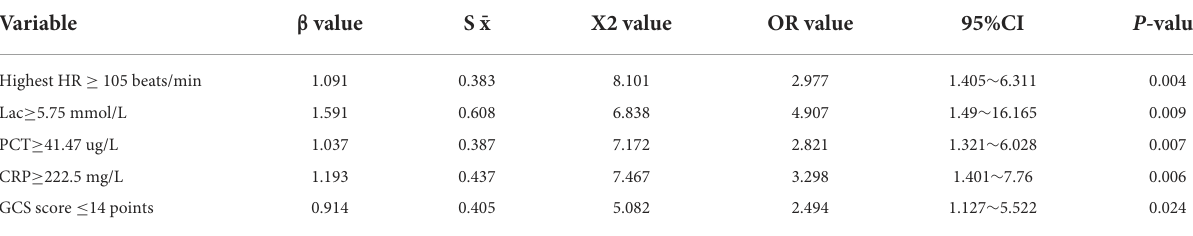
TABLE 4 Multivariate logistic regression analysis on the occurrence of septic shock.